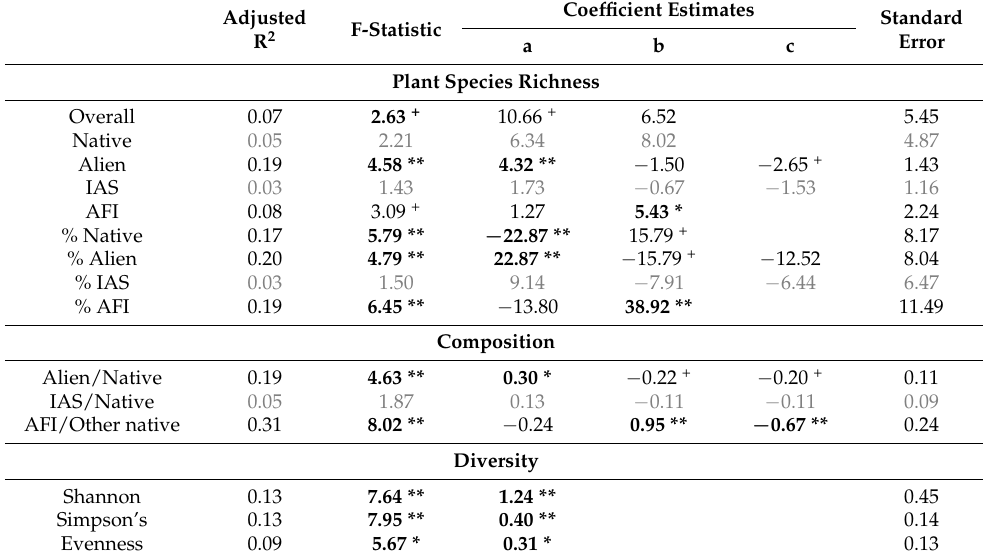
Table 2. Summary of linear (y = a *q + r), quadratic (y = a *q + b *q 2 + r), and polynomial (y = a *q + b *q 2 + c *q 3 + r) regression analyses of forest fragment size effect on plant species richness, composition, and diversity of plant communities. Significant coefficient estimates a, b, and c are in bold and marked as ** <0.01, * <0.05, + <0.1. Grey color represents statistically non-significant models. Murska šuma is not included in the analysis.